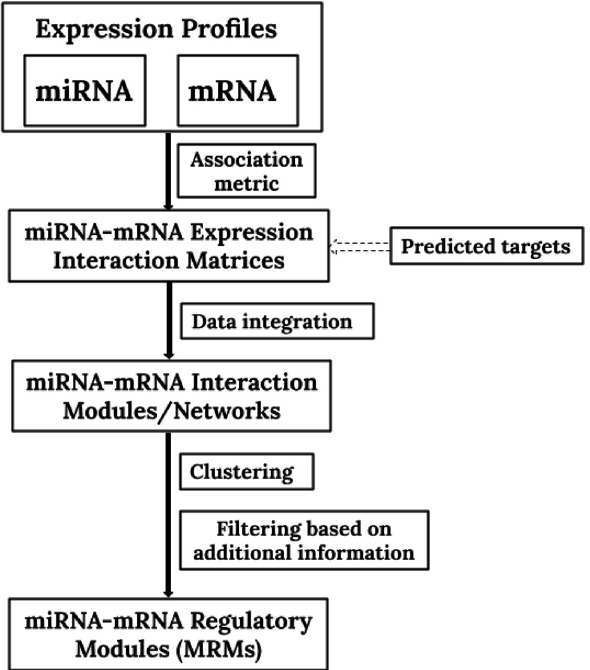
Figure 4: Schematic portrayal for the identification of